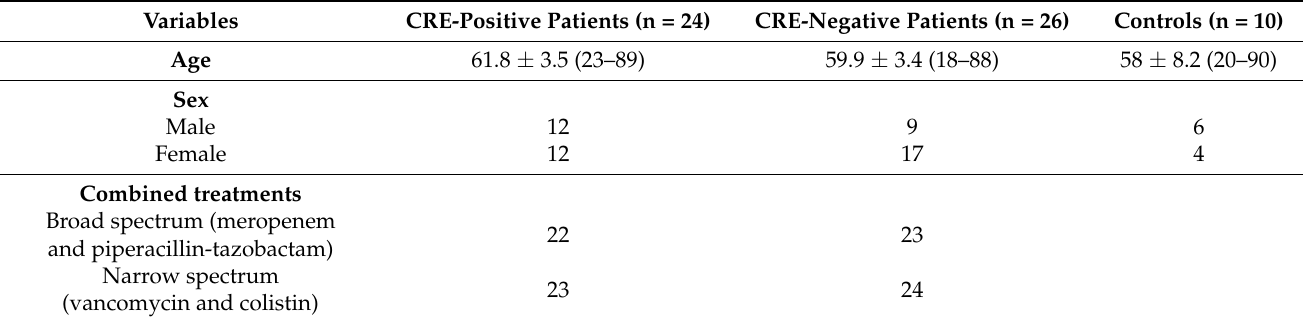
Table 1. Clinical characteristics of the